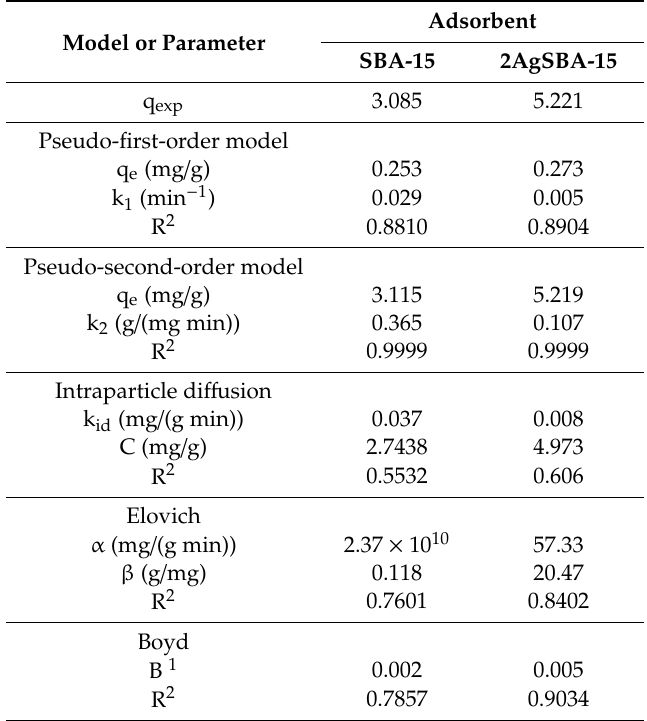
Table 2. Kinetic test results for the pseudo-first-order, pseudo-second-order, intraparticle di ff usion, and Elovich